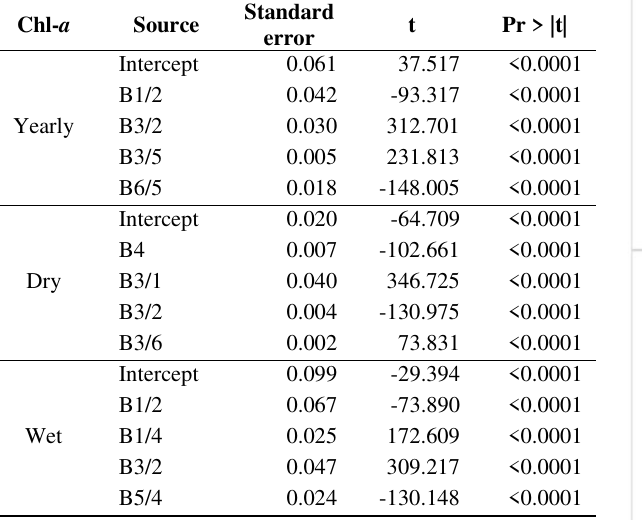
Table 6. Model parameters for the Chl- a models.